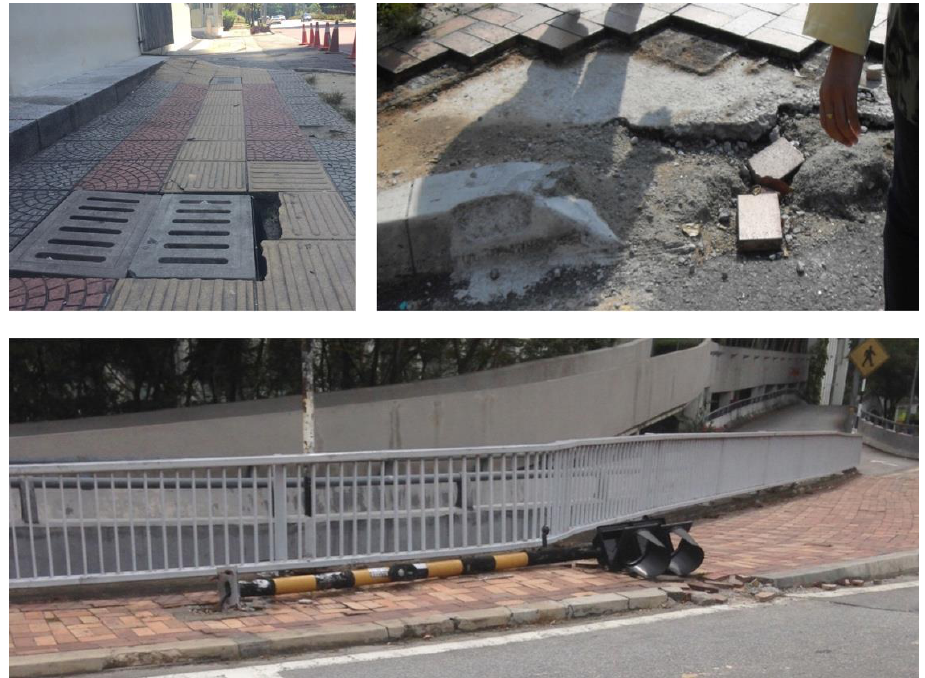
Figure 4. Damaged pedestrian paths in KL, Malaysia.